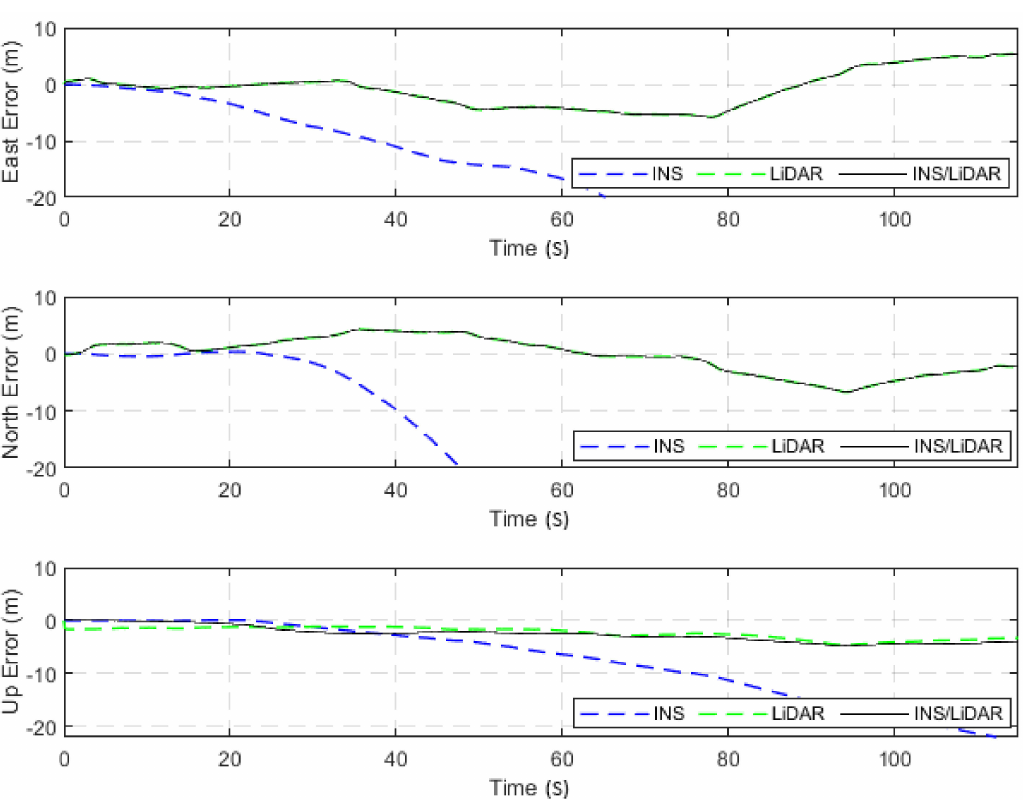
Figure 3. D-27—complete GNSS signal outage: position errors (ENU).